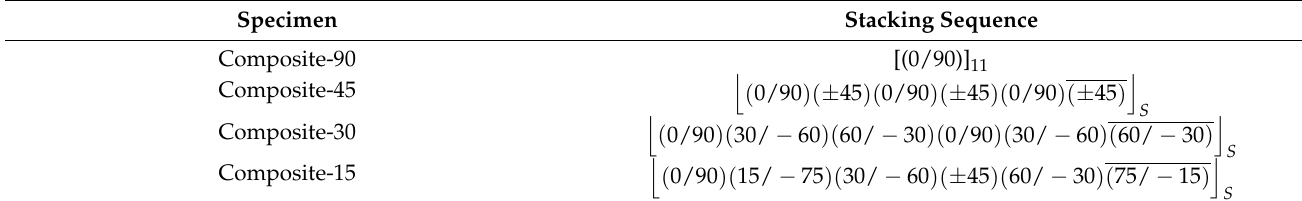
Table 2. Stacking sequences of composite